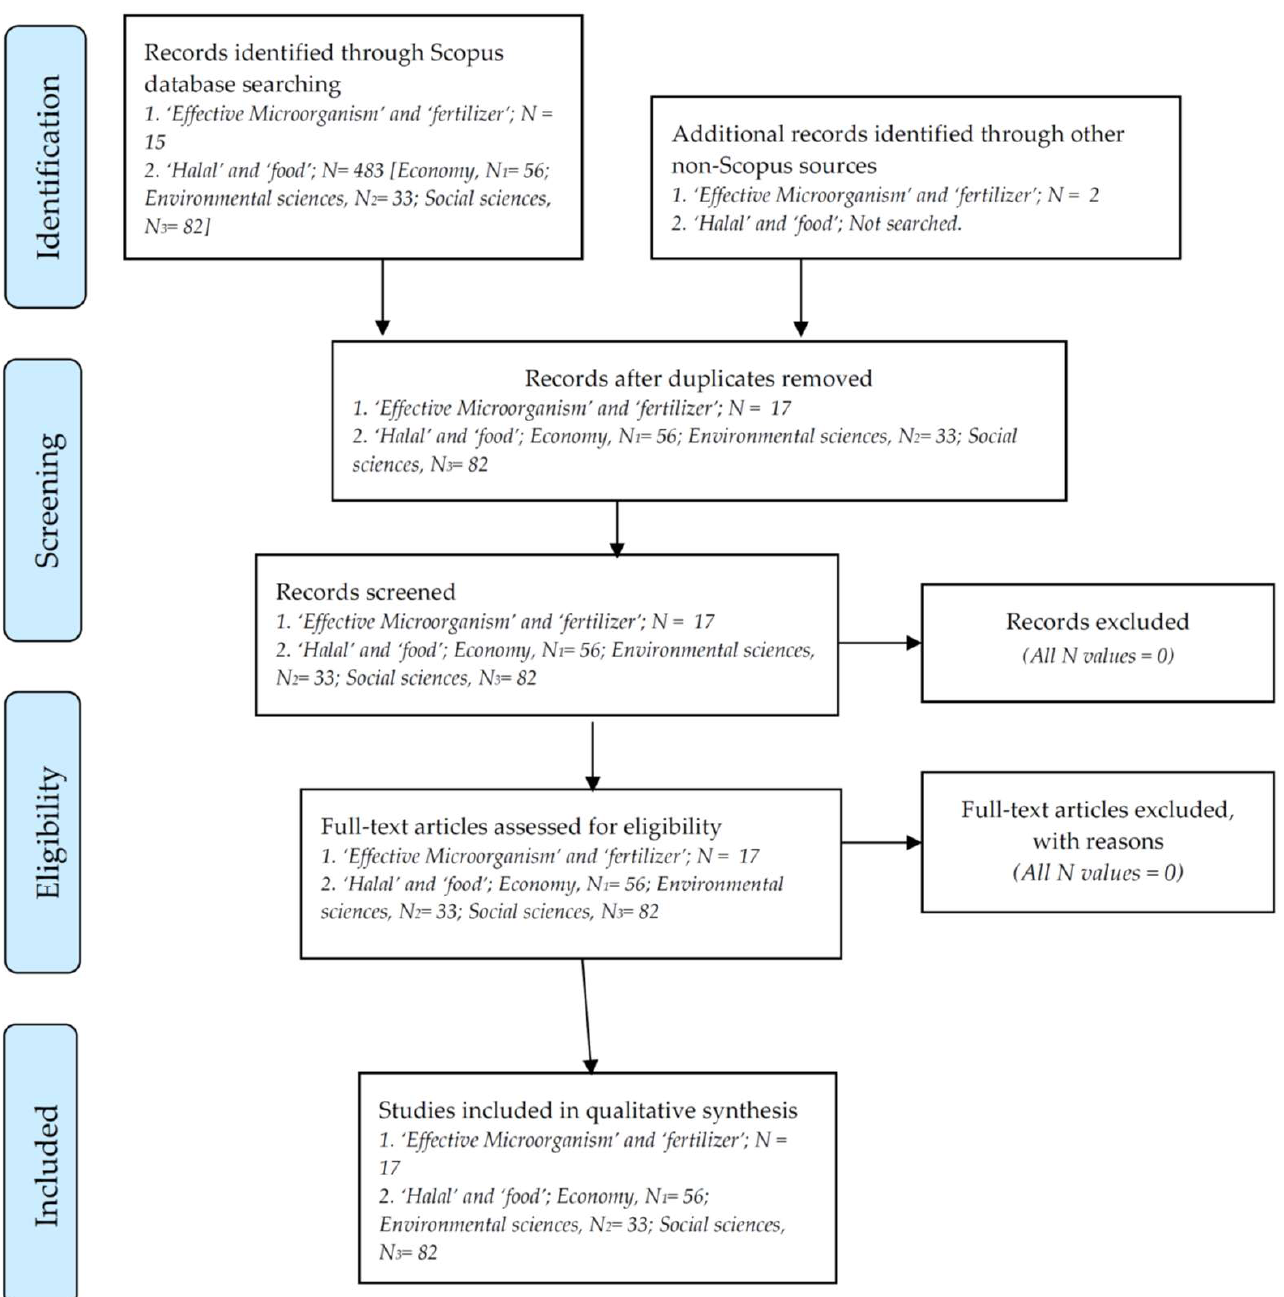
Figure 2. A flowchart of Preferred Reporting Items for Systematic Reviews and Meta-Analyses (PRISMA) that was used in the present study adapted from Moher et al. [173]. The detailed review for each publication is discussed in Table